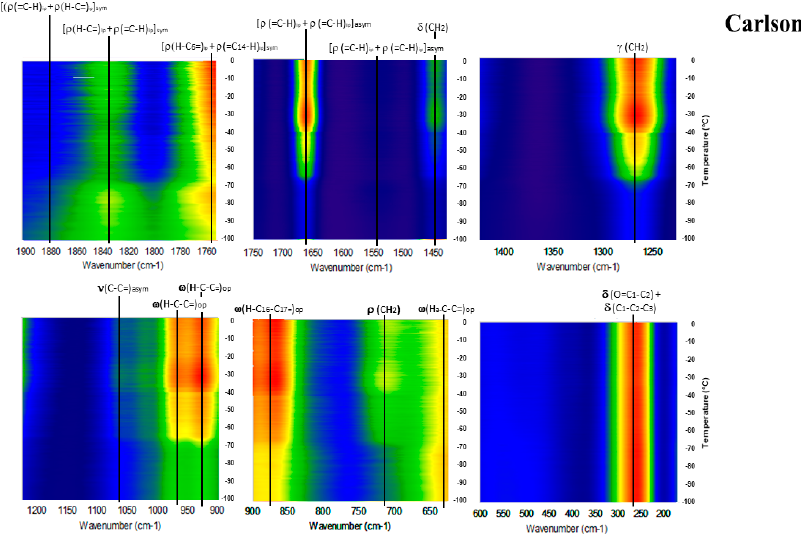
Figure 10. GTRS contour plot, Norwegian fish oil concentrate from anchovy, sardine, mackerel (CN).